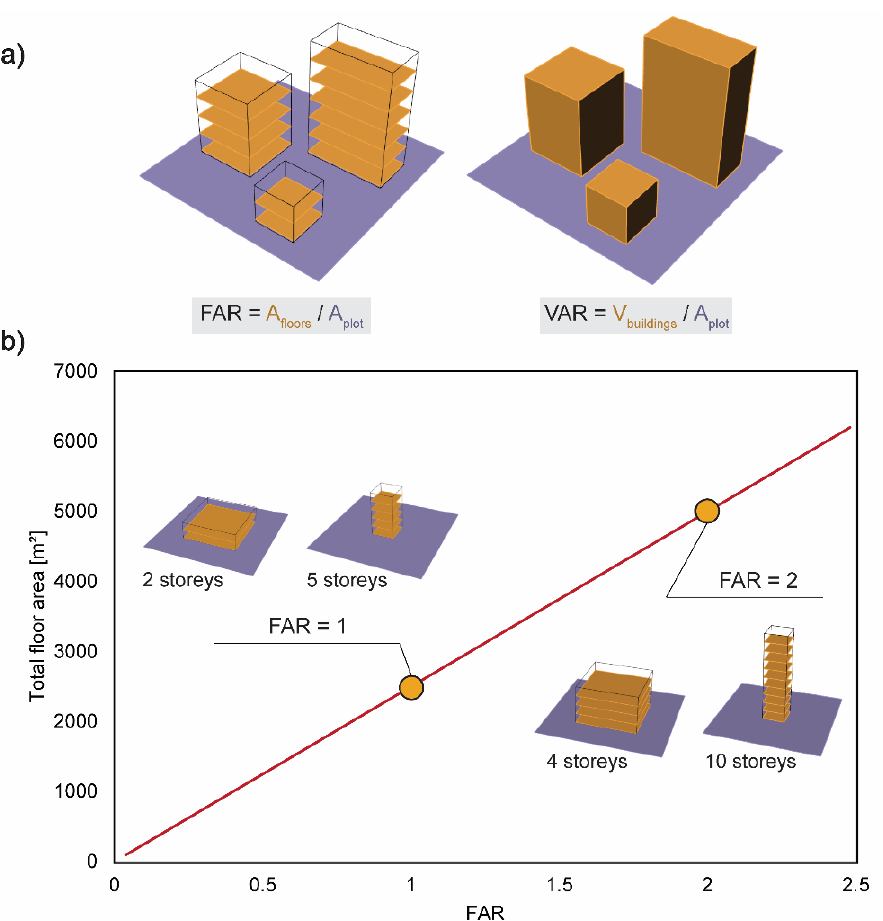
Figure 4. ( a ) Visualization of two twin morphological metrics, FAR and VAR, and their calculation methods. ( b ) Relationship between FAR and total floor area for an assumed plot size 50 × 50 m 2 . The graph contains examples of single building forms that can be created on the plot to abide by FAR equal to 1 and